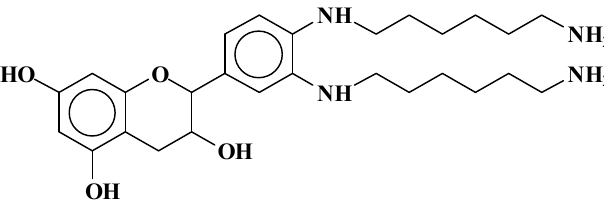
Figure 19. Covalently linked diamine onto catechin B-ring sites.